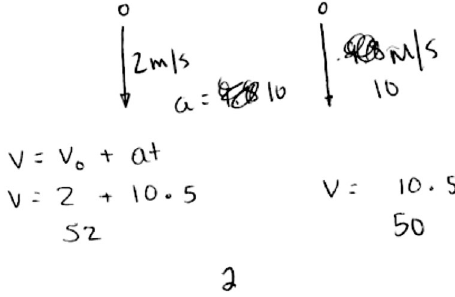
FIG. 1. The written component of Alex’s think-aloud solution to the two balls